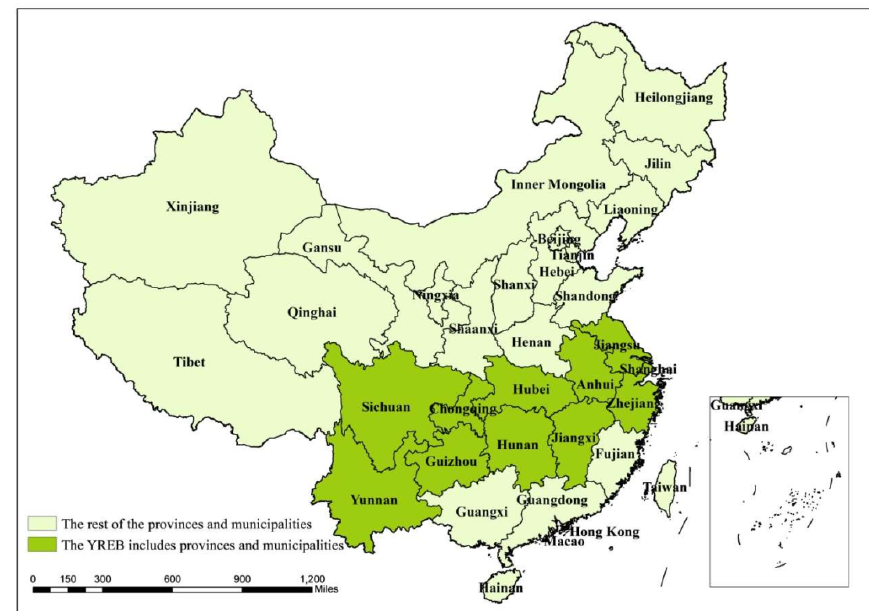
Figure 1. The Yangtze River economic belt research area (dark green).